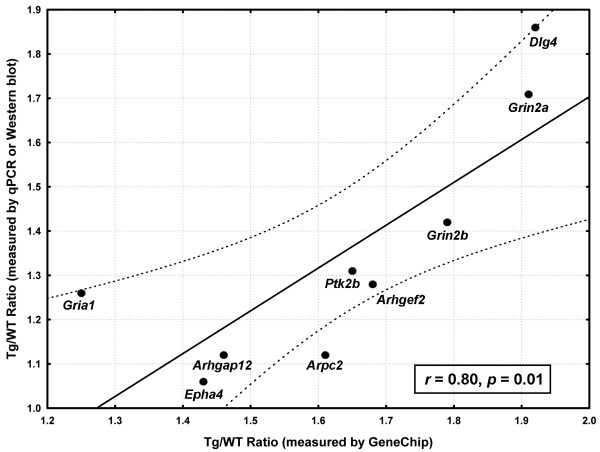
Correlation of GeneChip data with real-time quantitative PCR or immunoreactivity data of nine important genes with significantly altered expression in the Glud1 mice. To validate the GeneChip data, confirmatory data were collected by both real-time quantitative PCR and Western blot analyses. Three replicate measurements were performed on each gene (or protein) and the mean value is shown here. Real-time quantitative PCR was used for the measurements of Arhgap12, Arhgef2, Arpc2 and Epha4, while Western blots were used for the products of Dlg4, Gria1, Grin2a, Grin2b and Ptk2b. The Pearson correlation coefficient (r) between the GeneChip and confirmatory data, and the estimated p value, are shown at the bottom. The best-fit linear regression line (solid line) and the estimated 95% confidence limits (dashed lines) are also shown.